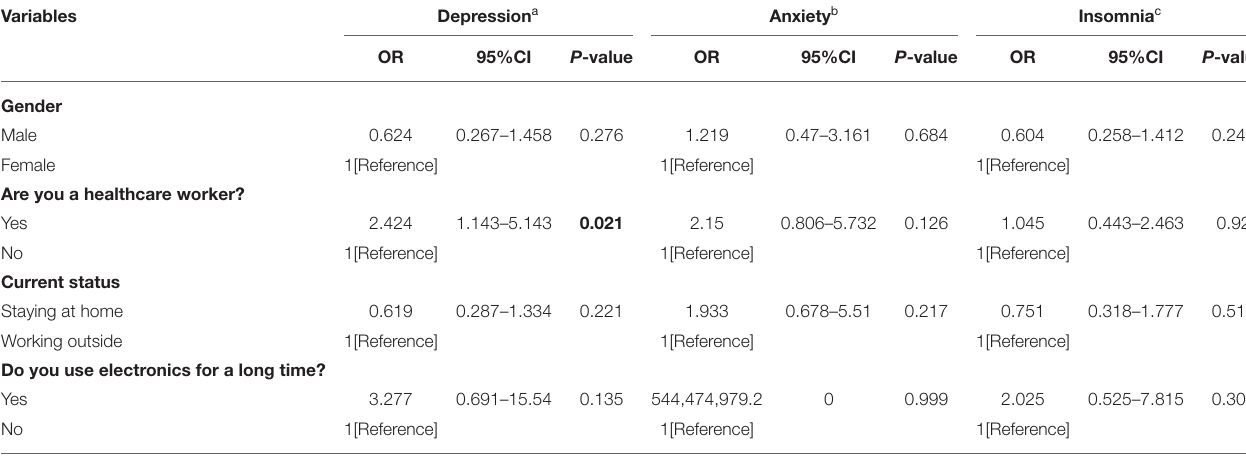
TABLE 4 | Binary logistic regression analysis of risk factors associated with symptoms of depression, anxiety and